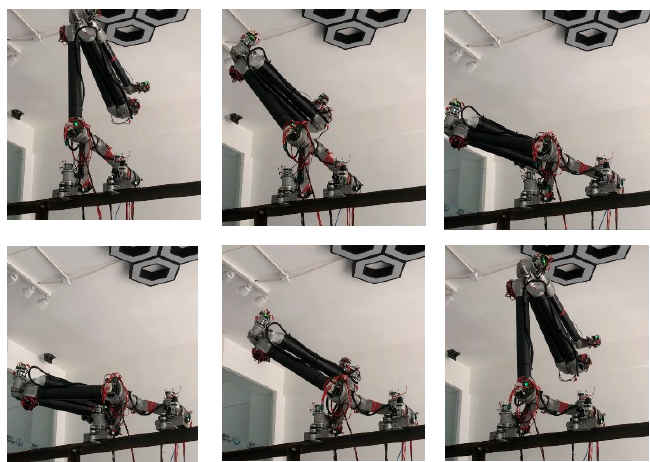
Figure 23. The joint angles of the climbing mechanism in the experiment.